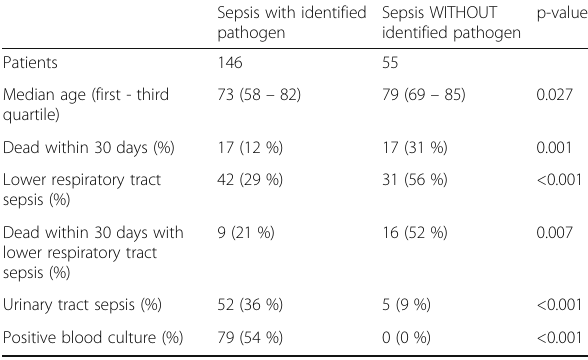
Table 1 (abstract P19). See text for